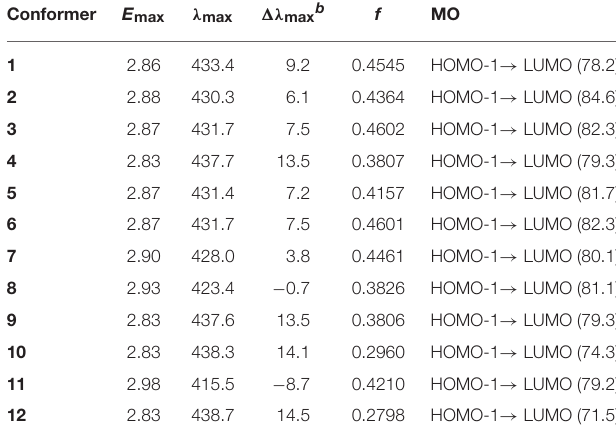
TABLE 7 | Impact of functionals on spectral shift of conformer 5 ( λ max in nm) a . Functional